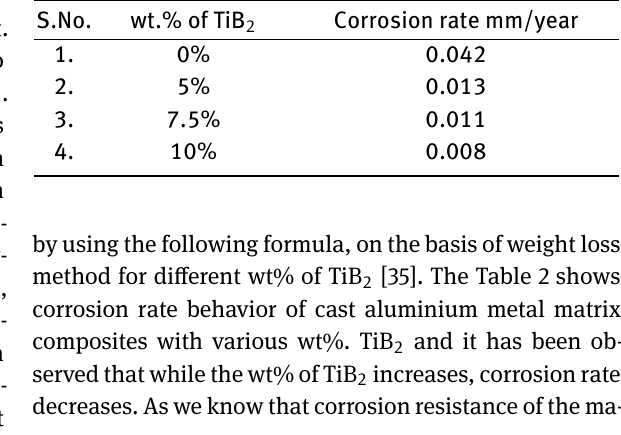
Table 2: Corrosion rate of the Aluminium metal matrix composites